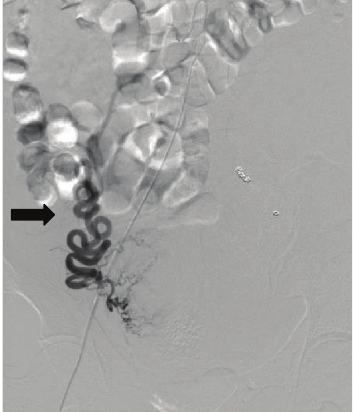
Figure 5: Right ovarian artery angiogram: markedly dilated and tortuous right ovarian artery with distal branches supplying right side of the uterus